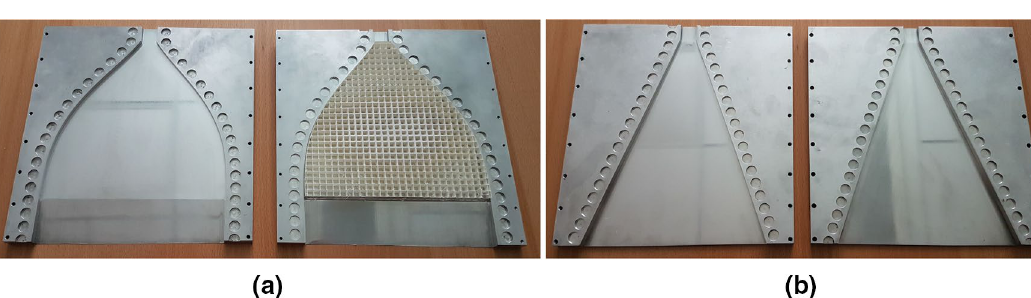
Figure 4. Rendition of ( a ) the H-plane horn lens antenna, and ( b ) the reference H-plane horn antenna.